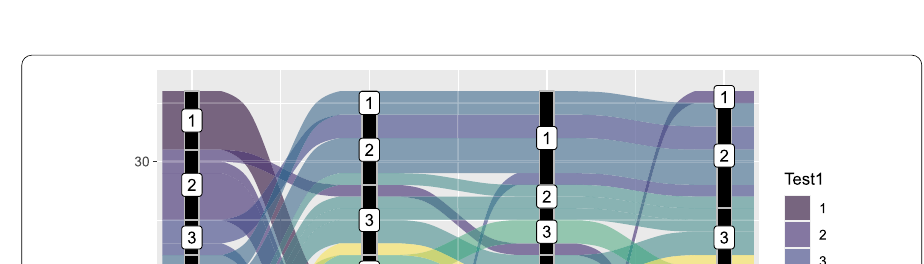
Fig. 18 Betweenness (directed) centrality distributions, scatterplots, and Spearman correlation coefficients for the Spring 2016 exams